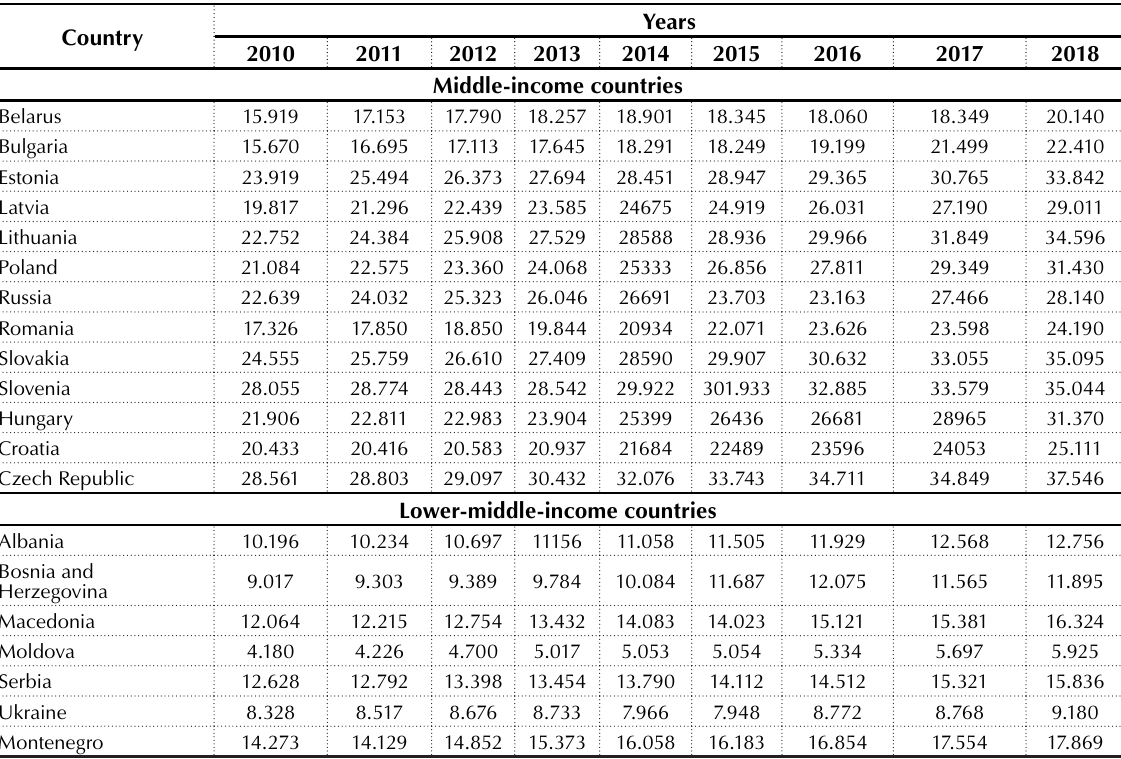
Table 3. Dynamics of real per capita GDP in post-socialist Central and Eastern European countries Source: Data for the Sustainable Development (2017) and World Development Indicators